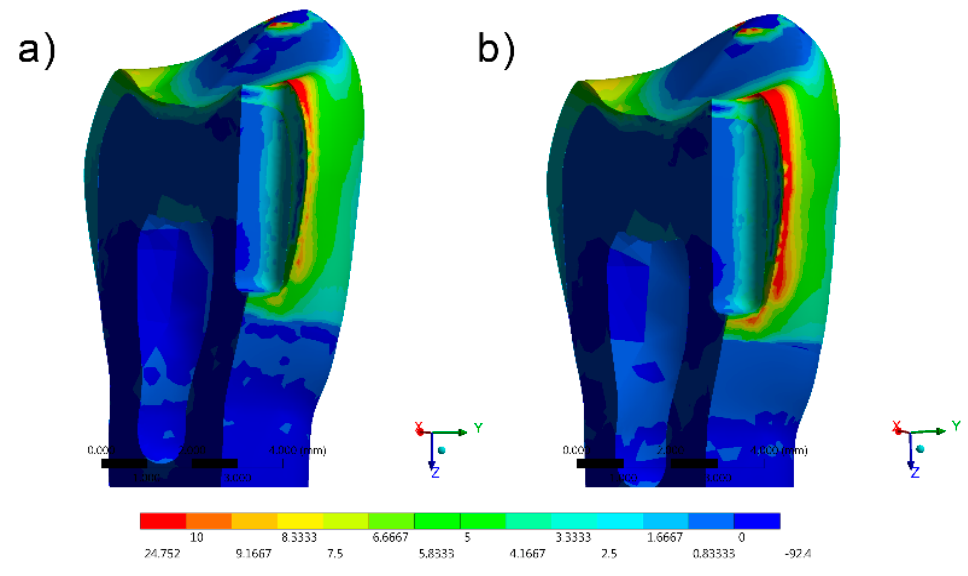
Figure 7. FEA Maximum Principal Stress results in the vertical slot design. ( a ) Bulk-fill flowable and ( b ) conventional.